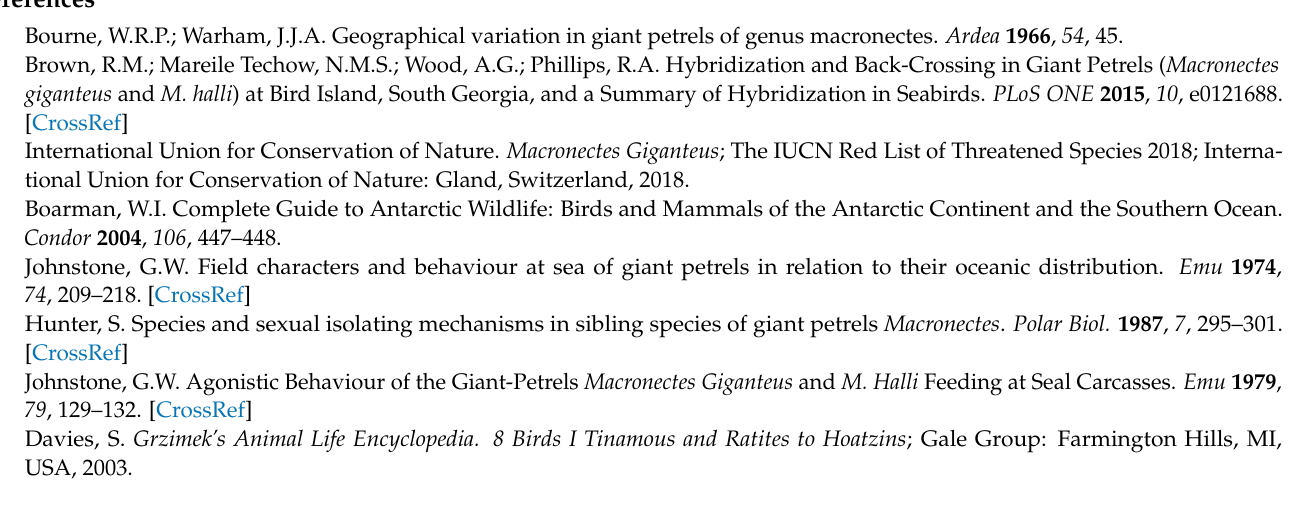
KEGG pathways. The red color indicates expanded